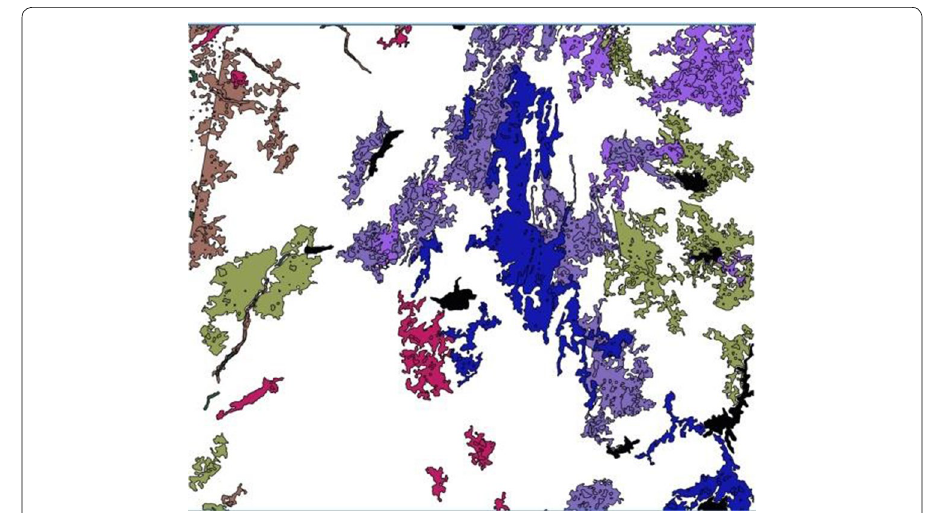
Fig. 18 The biggest 10 shapes from each cluster